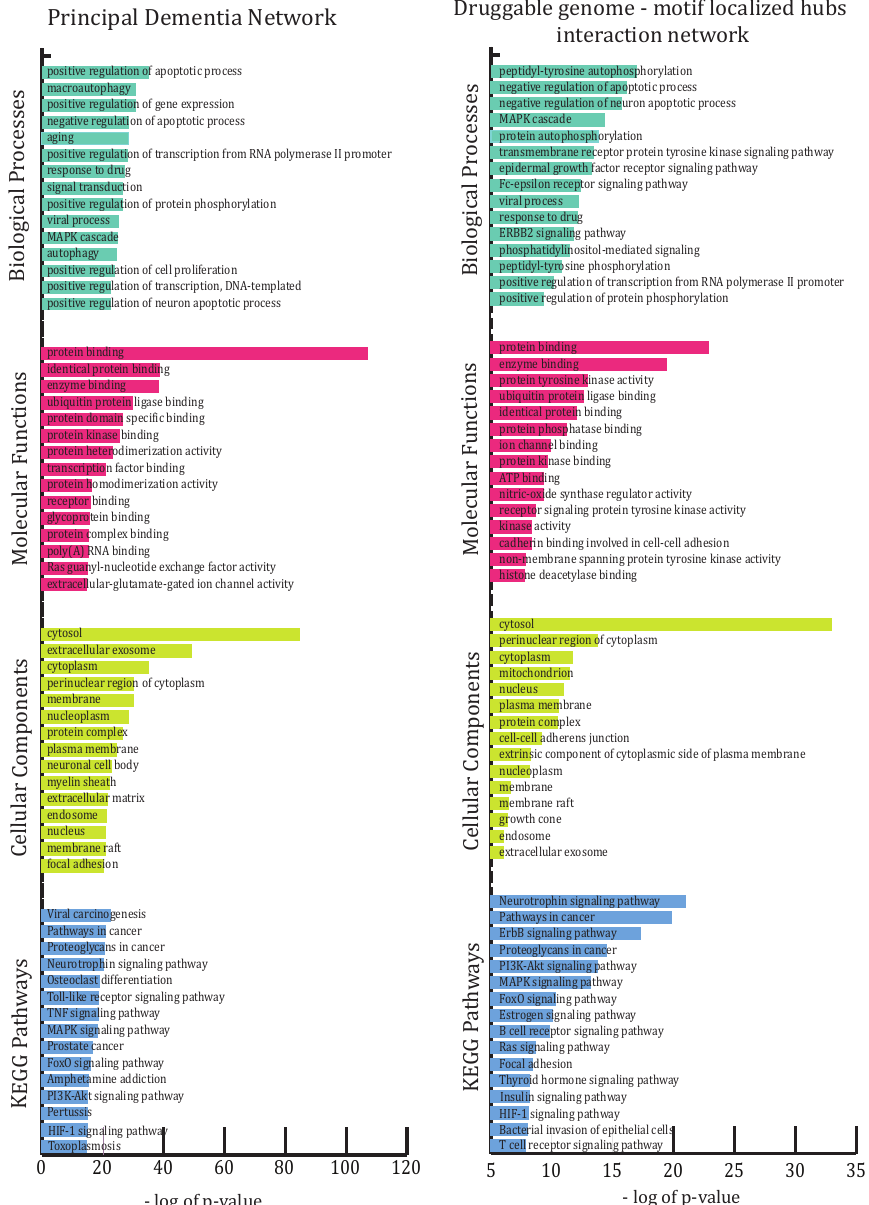
components) and KEGG pathways (see Figure 2).